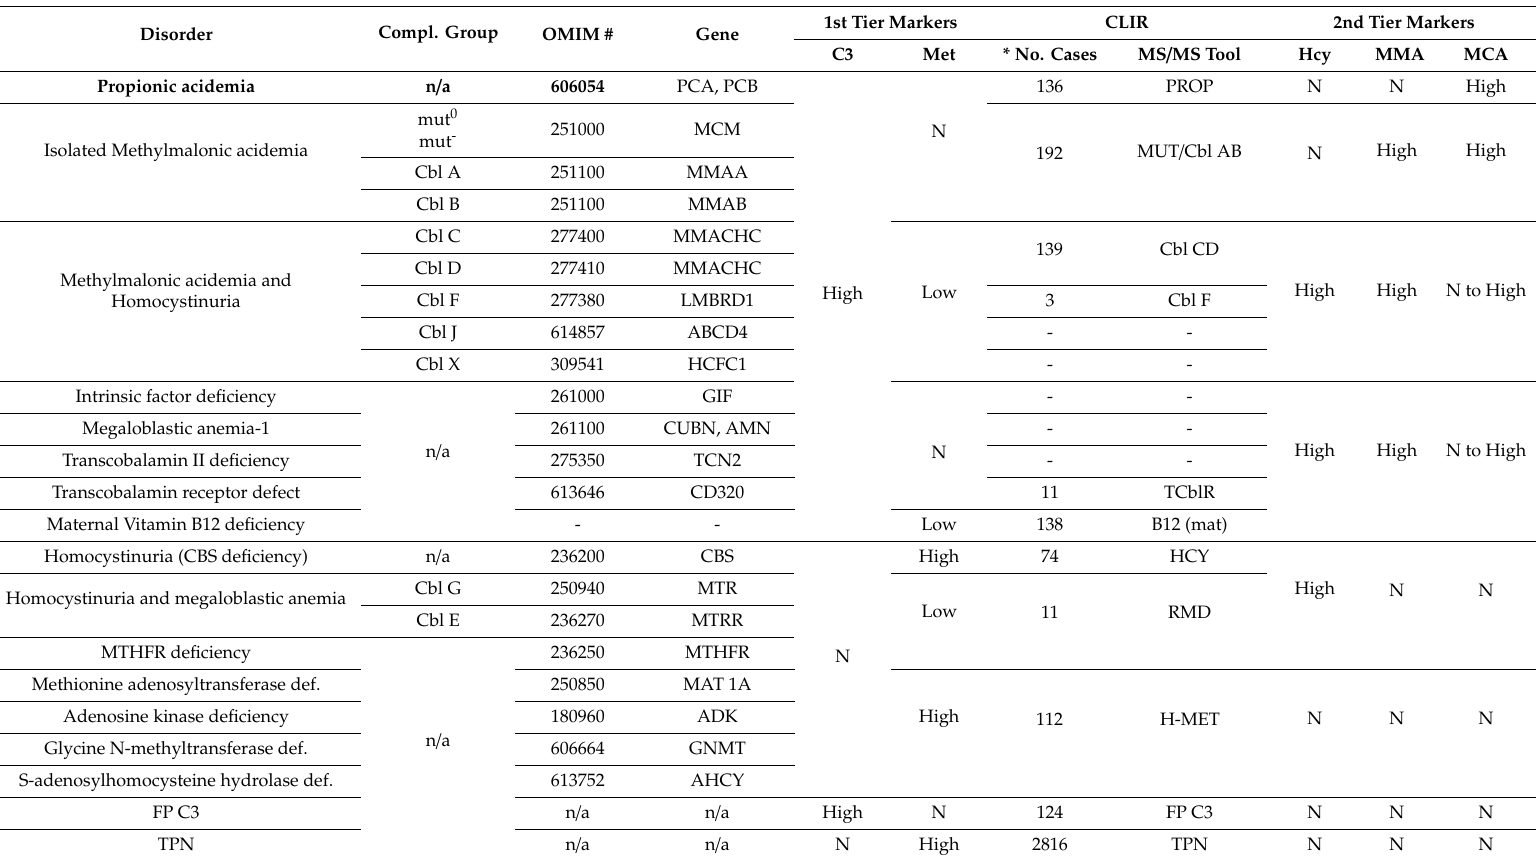
Table 1. Markers of inherited and acquired disorders of propionate, cobalamin, and methionine metabolism, count of cases, and Collaborative Laboratory Integrated Reports (CLIR),